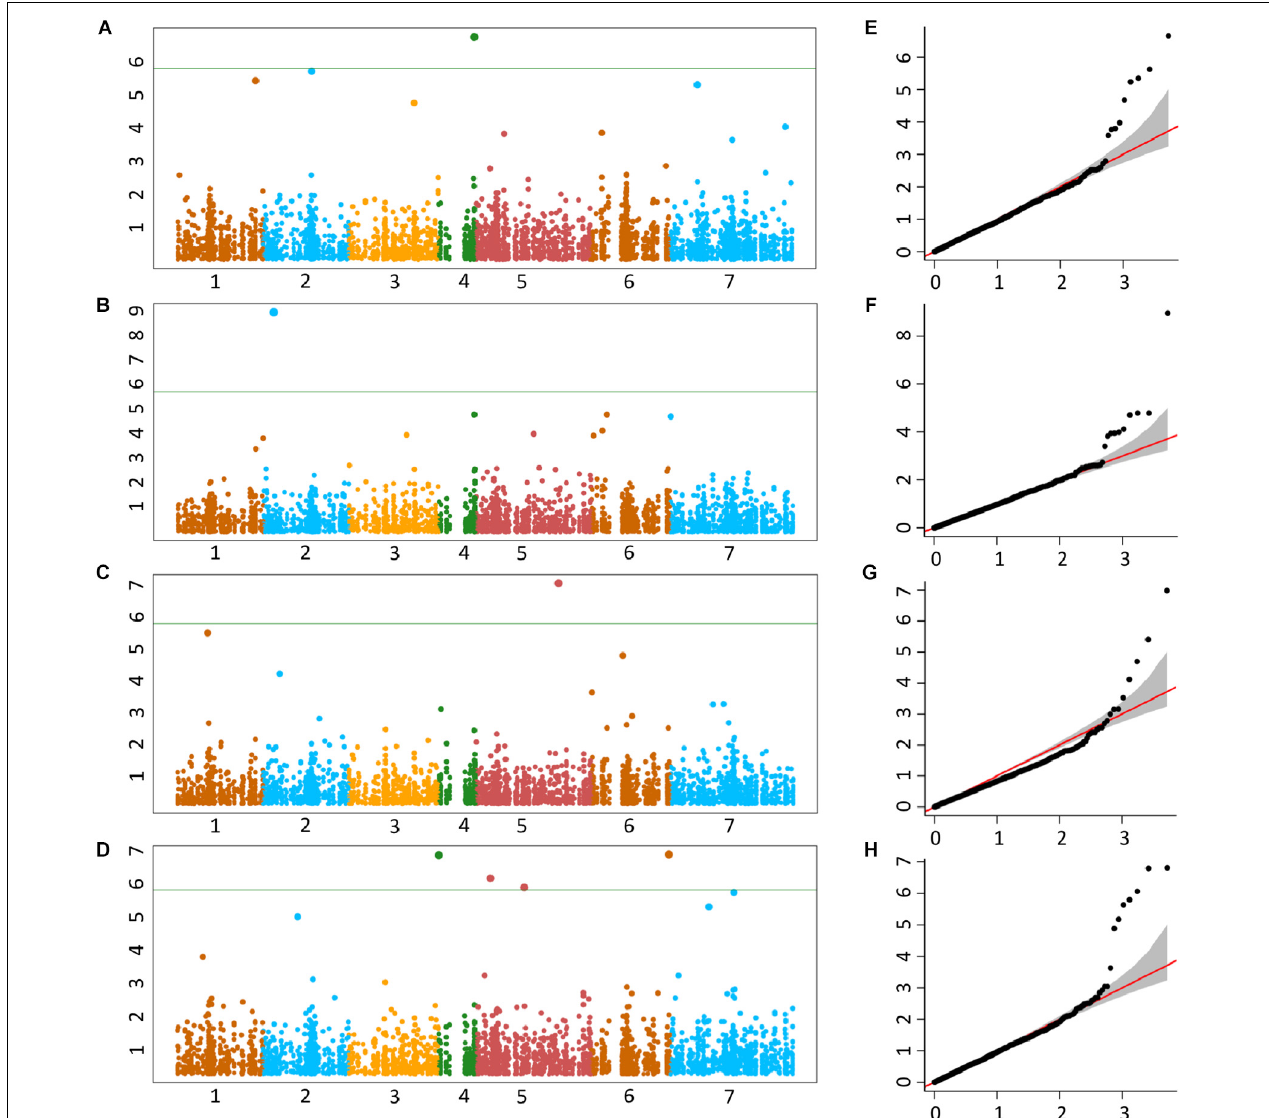
FIGURE 4 | Manhattan plots representing seven chromosomes carrying the significant markers detected by MLM models using BLUP values for grain (A) Fe, (B) Zn, (C) Cu, and (D) Mn. Quantile–quantile (Q-Q) plots for grain Fe, Zn, Cu, and Mn (E–H) showing expected null distribution of p -values, assuming no associations, represented as red solid line; distribution of p- values observed using mixed linear model (MLM) represented as a black